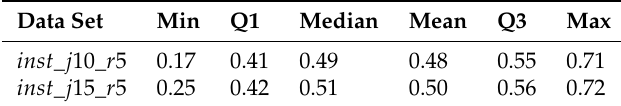
Table 4. X ( I ) values for instances of datasets inst _ j 10_ r 5 and inst _ j 15_ r